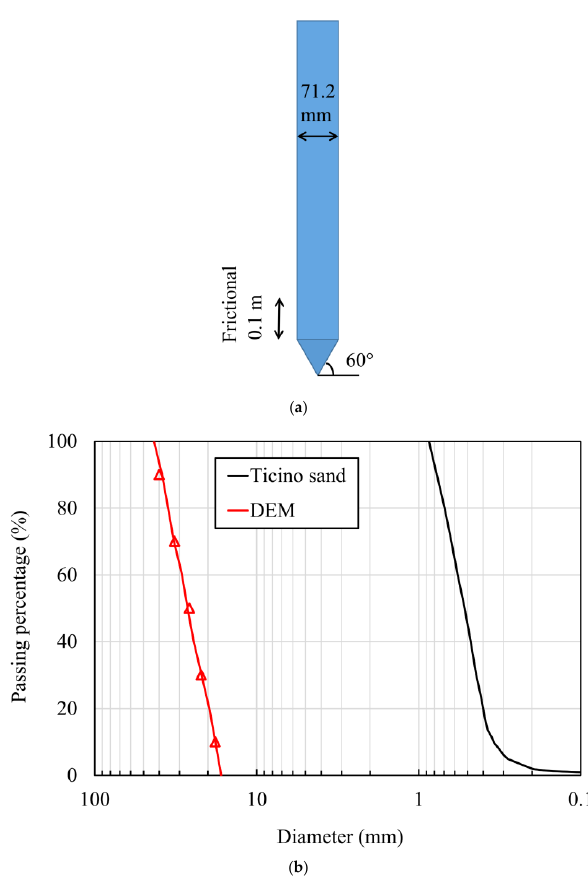
Figure 9. Configurations in the numerical model of cone penetration test ( a ) size of cone ( b ) particle size distribution of sand.